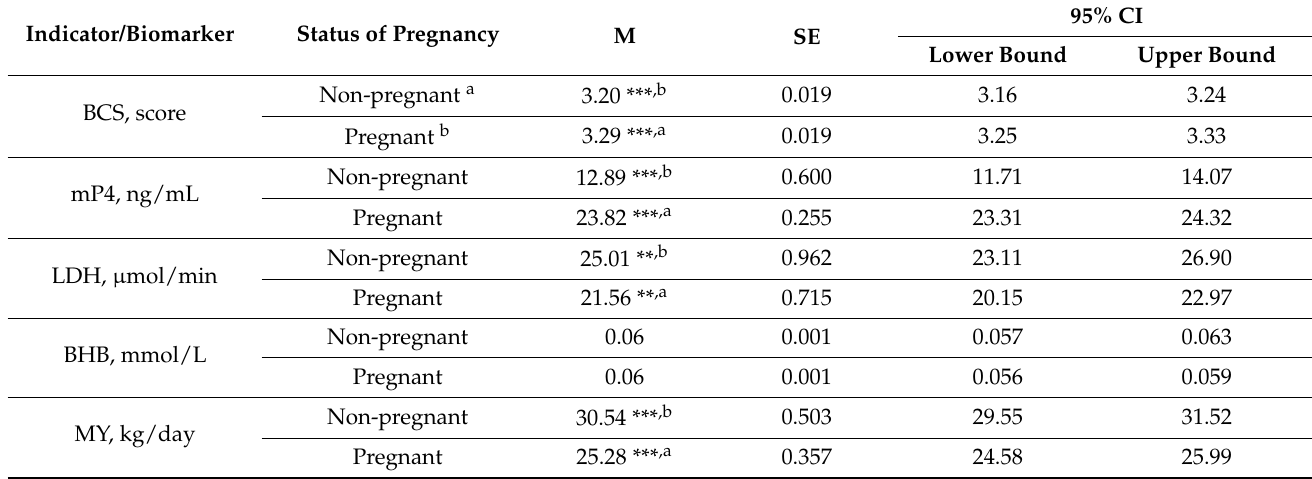
Table 1. Means and standard errors of the mean of biomarkers based on the pregnancy status of cows from the day of oestrus to 7 days post-oestrus.